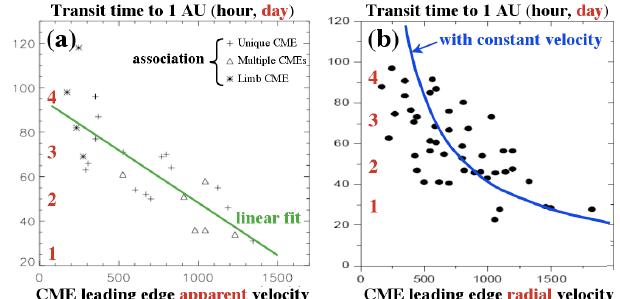
Fig. 1. Examples of eruptions located close to the solar disk cen- ter and with an associated MC detected in the Earth vicinity. The images are taken: (a) in X-rays (Watari et al., 2001), and (b) in EUV (Webb et al., 2000). The blue arrow indicates the MC axis de- duced at 1 AU from in-situ data (see Fig. 5 for the definition of the MC axis). Other aspects of the event (b) are also shown in Figs. 7 and 12.